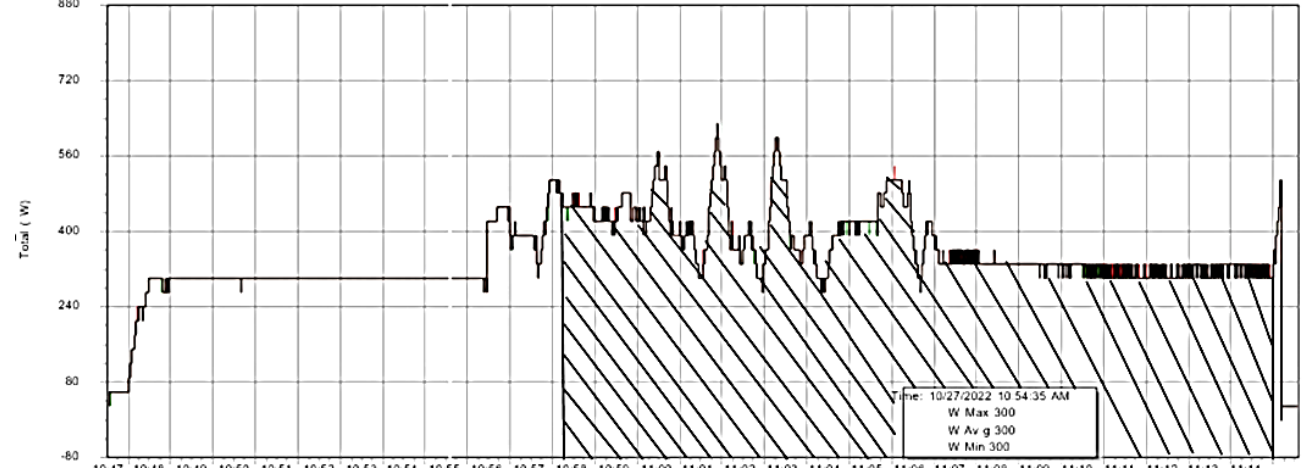
Figure 4. Experimental power vs. time graph in the RUN 1.